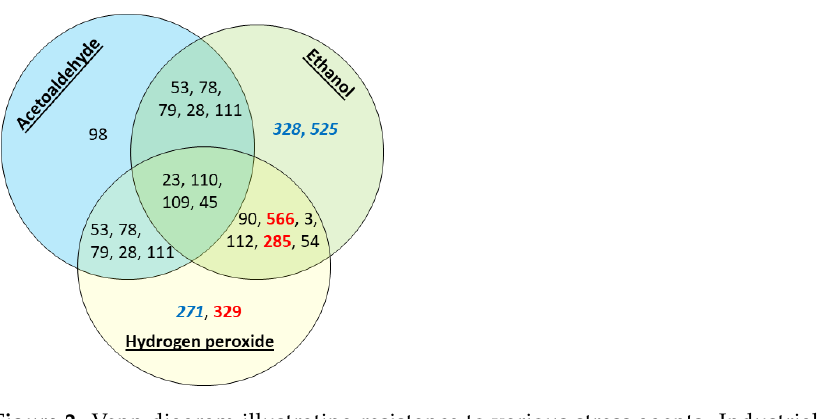
Figure 2. Venn diagram illustrating resistance to various stress agents. Industrial flor strains are shown in red font, wine strains in blue font, and environmental isolates in black font.